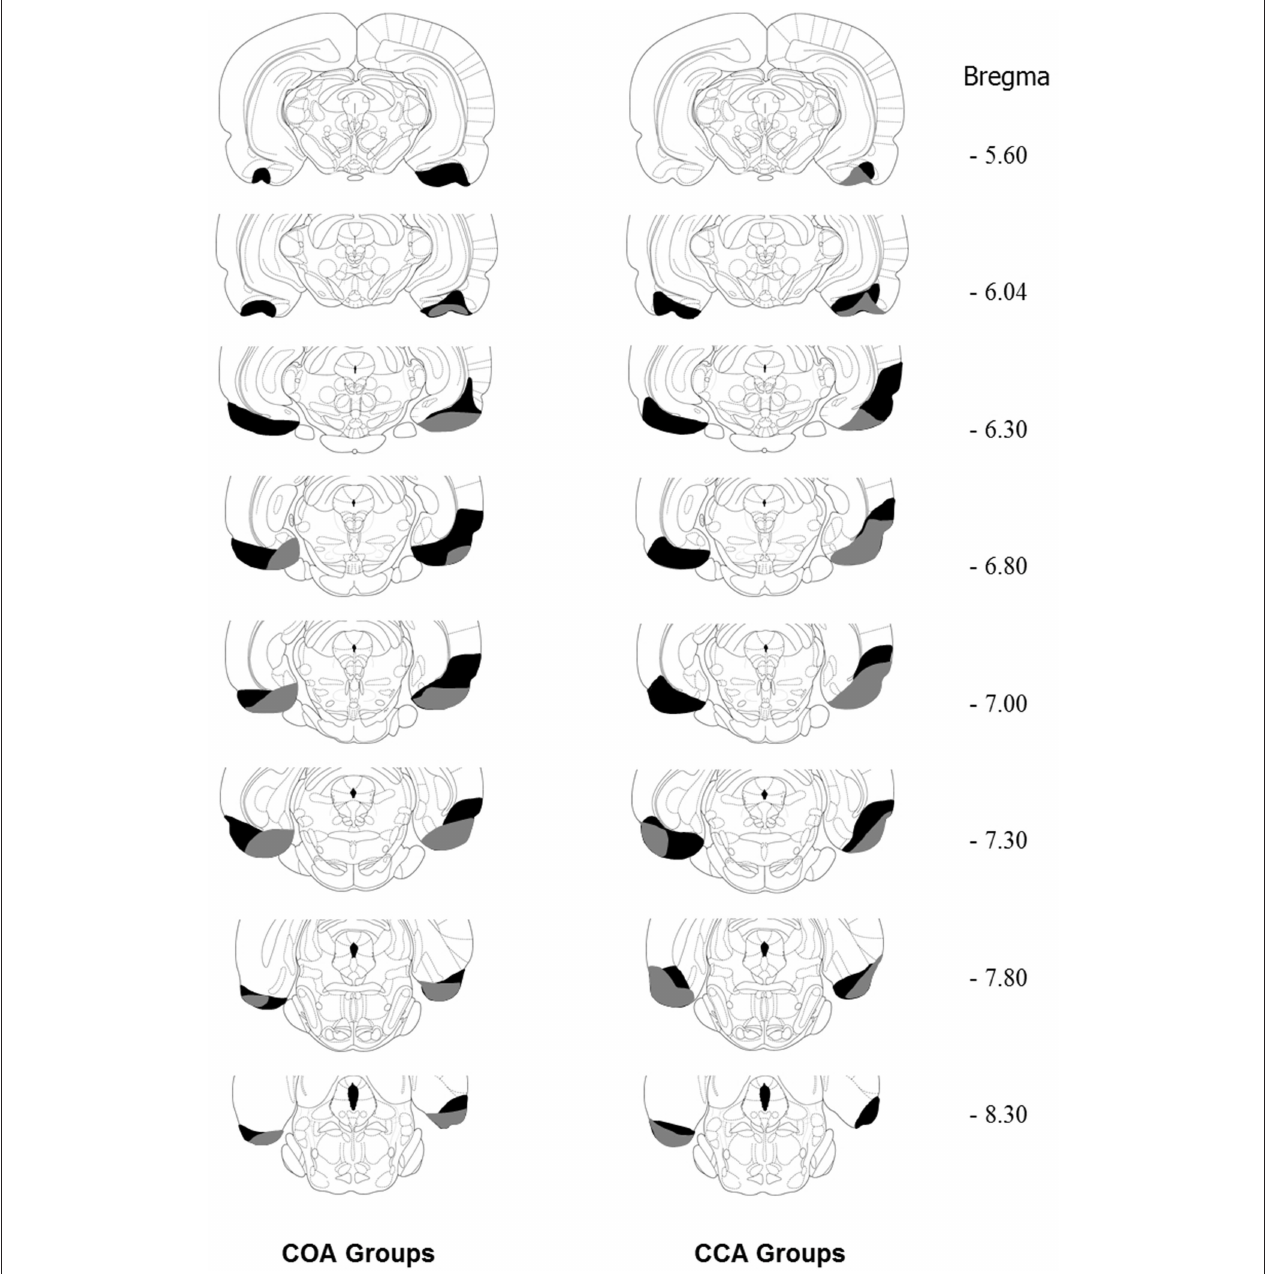
FIGURE 2 | Diagram of coronal sections (between − 5.60 and − 8.30mm from bregma; according to the Paxinos and Watson stereotaxic atlas, 1998) showing the extent of the smallest (gray area) and the largest (black area) EC lesion in the COA and CCA groups. From The Rat Brain in Stereotaxic Coordinates , by Paxinos and Watson (1998). Copyright 2006 by Elsevier. Adapted with